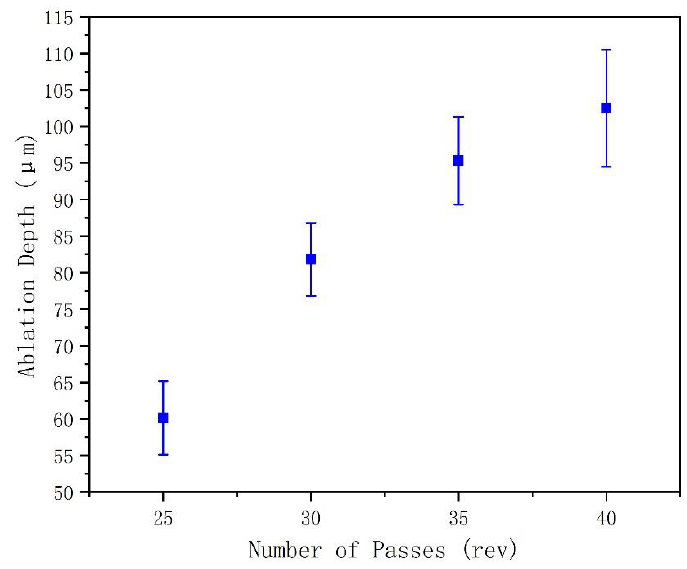
Figure 8. Effect of number of passes on hole-depth in a spiral drilling cycle.